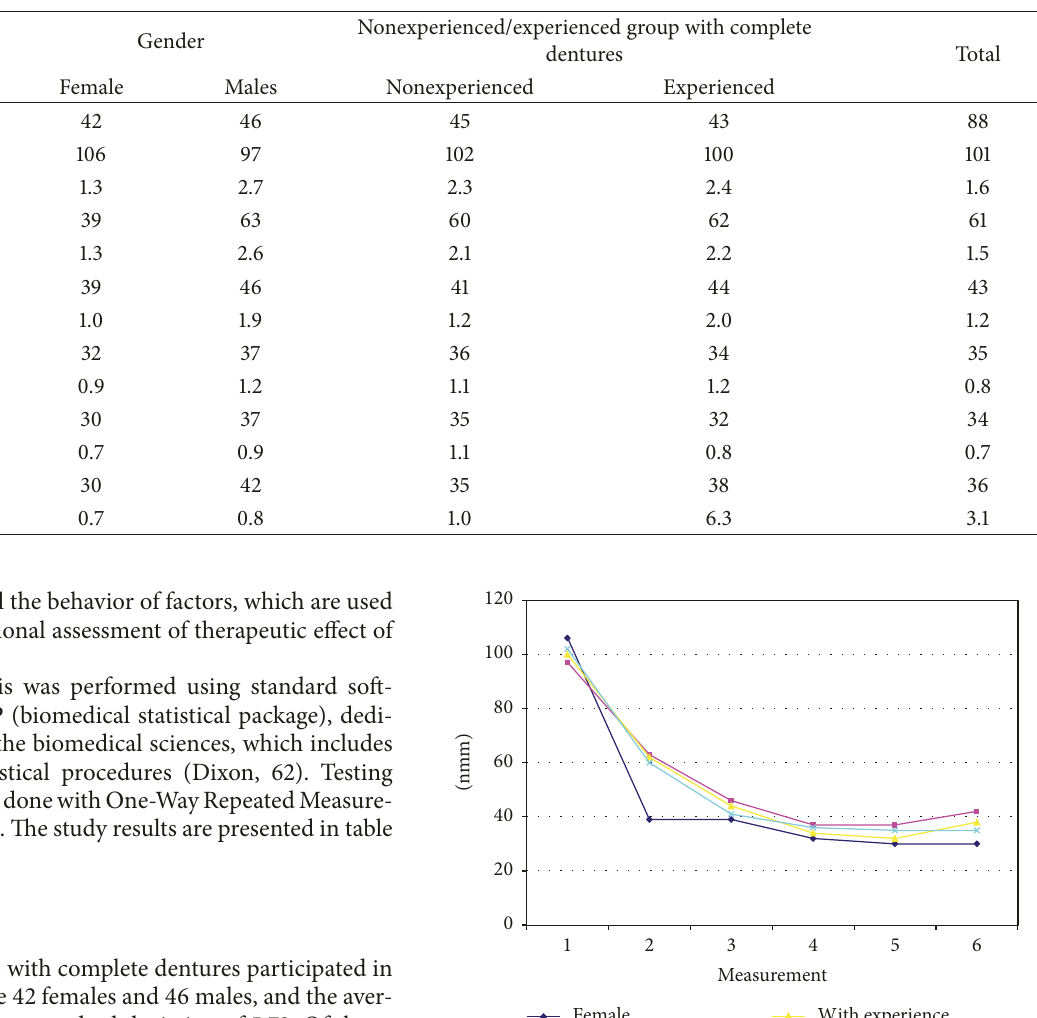
Table 2: Dynamics of sensibility threshold for interocclusal thickness.